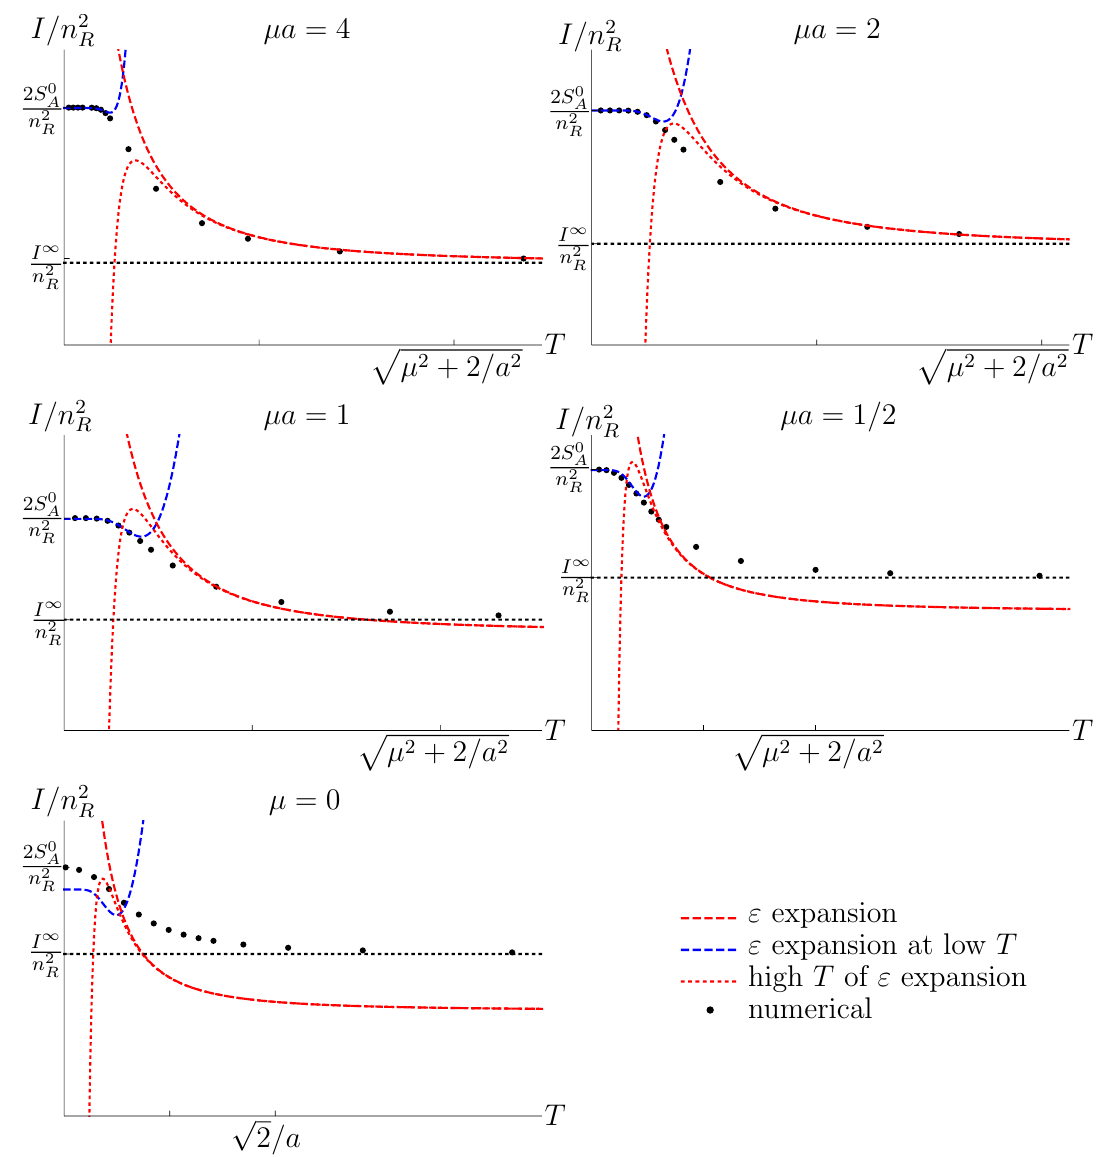
Figure 4 . The area law term coe(cid:14)cient of the mutual information as function of the temperature. The dashed lines are the low and high temperature expansions of the mutual information, whereas the dotted lines are the asymptotic values for T ! 1